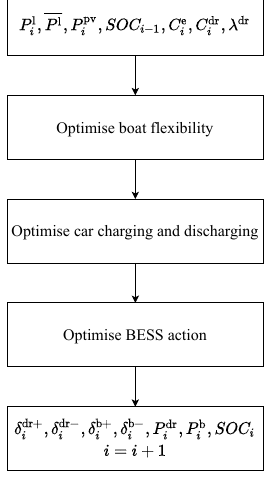
Figure 5. Optimal ICES operation